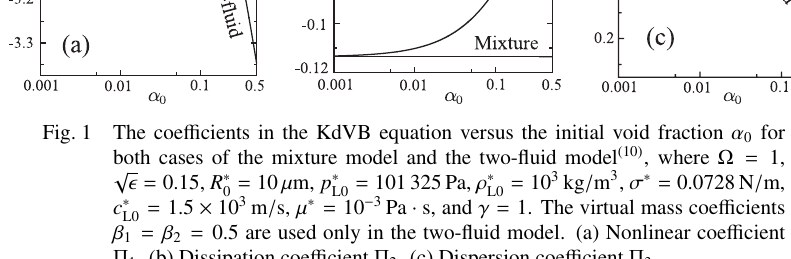
Fig. 1 The coe ffi cients in the KdVB equation versus the initial void fraction α 0 for both cases of the mixture model and the two-fluid model (10) , where Ω = 1, √ (cid:3) = 0 . 15, R ∗ = 10 μ m, p ∗ = 101325Pa, ρ ∗ 0 L0 = 1 . 5 × 10 3 m / s, μ ∗ = 10 − 3 Pa · s, and γ = 1. The virtual mass coe ffi cients c ∗ L0